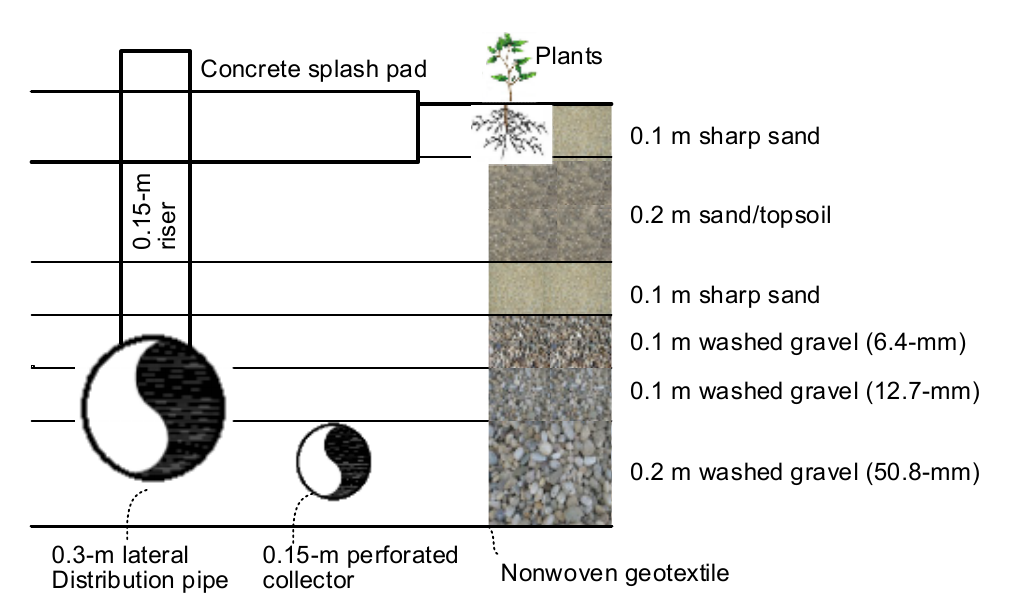
Figure 2. Vertical configuration of Harbor Brook vertical flow constructed